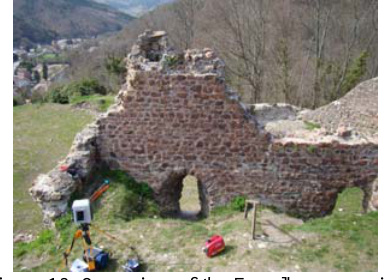
Figure 13. Overview of the Engelbourg project